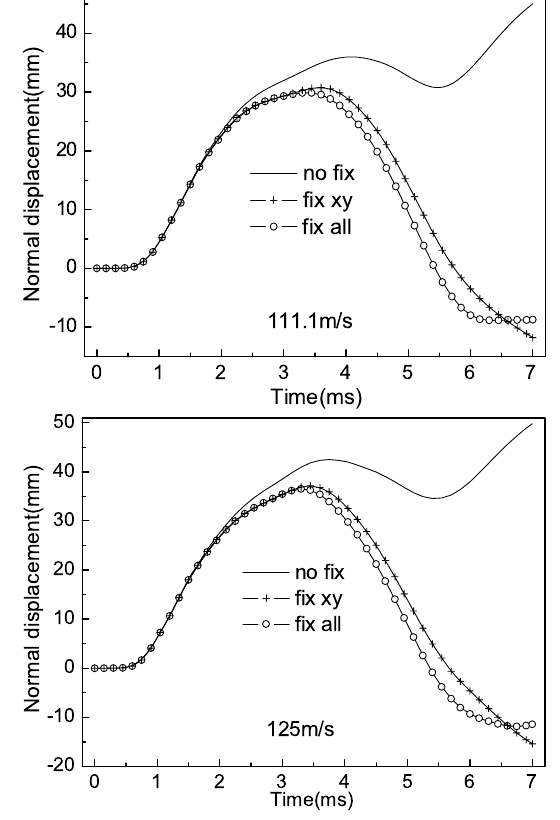
Fig. 15. Time history of normal displacement at the center on inner surface for different boundary